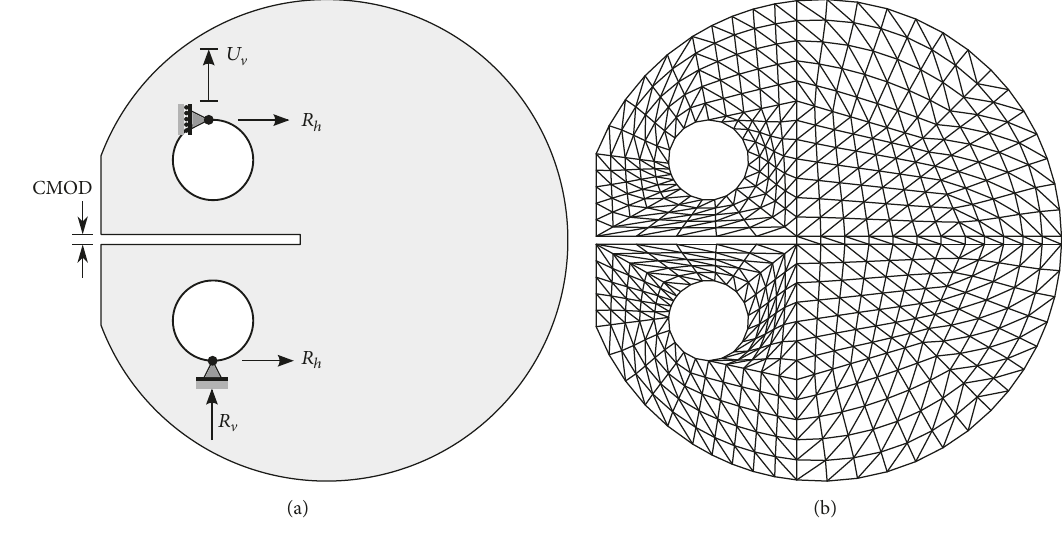
Figure 6: Finite element model, (a) supports, and (b)